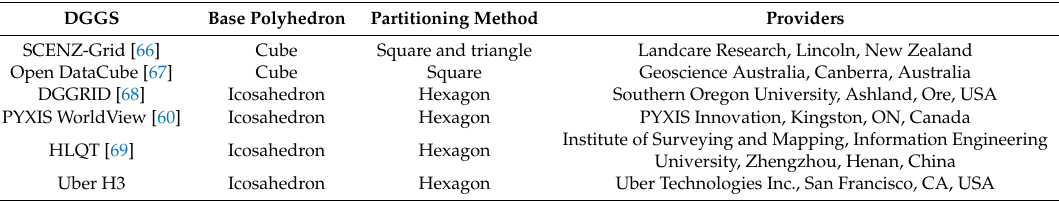
Figure 6. ( a ) Tetrahedron, ( b ) cube, ( c ) octahedron, ( d ) dodecahedron, and ( e ) icosahedron. Table 2. Several existing DGGS solutions.